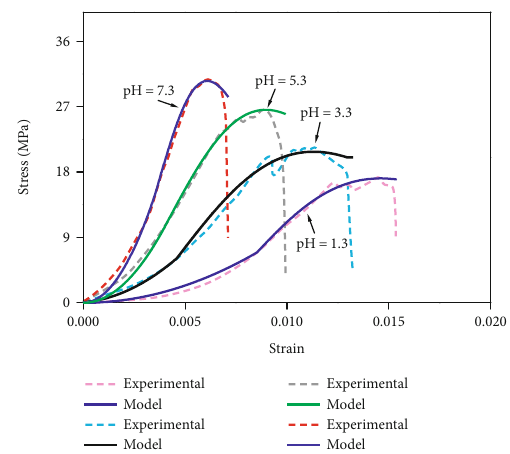
Figure 12: Uniaxial loading test curve and model curve of rock after acid water